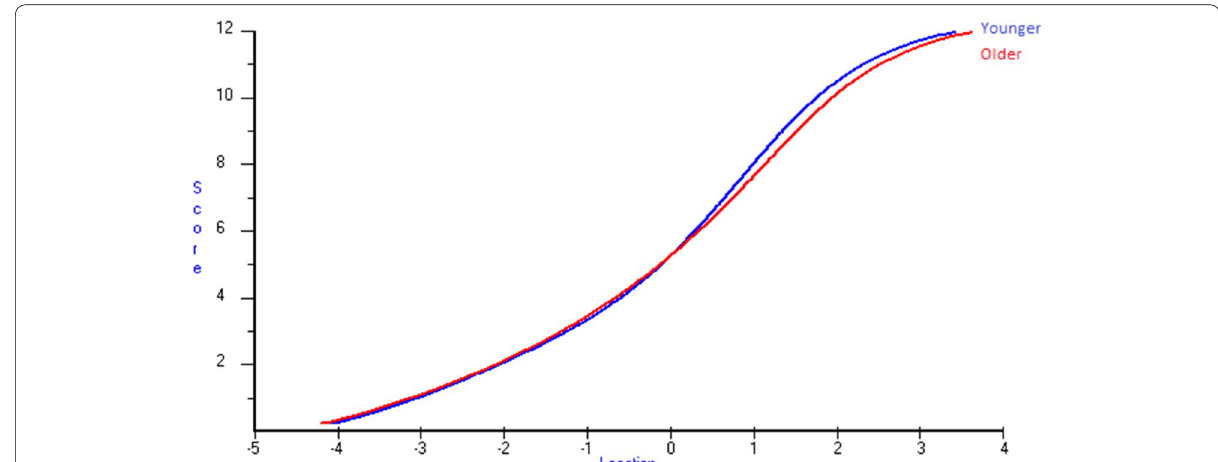
Fig. 4 The Minimal Insomnia Symptom Scale–Revised raw scores (y‑axis, higher scores values on the insomnia continuum (x‑axis, positive values